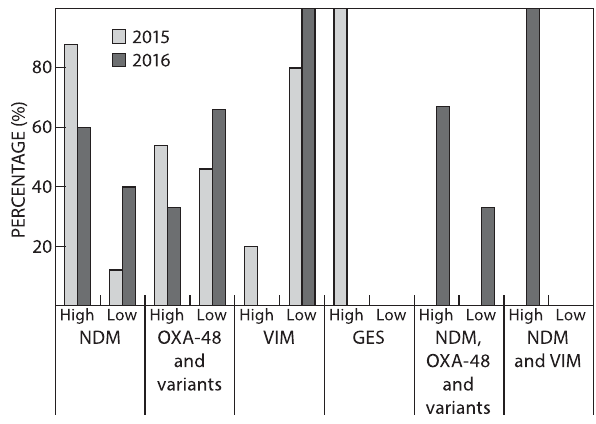
Figure 3: Predominant members of the Enterobacteriaceae family ident- i fi ed as CRE.